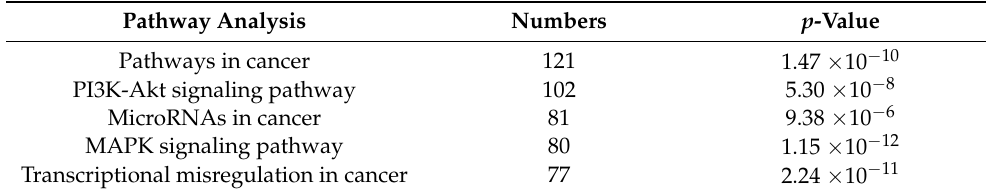
Table 2. The pathway enrichment analysis by applying The Database for Annotation, Visualization and Integrated Discovery (DAVID) in core GWGEN of triple-negative breast cancer.